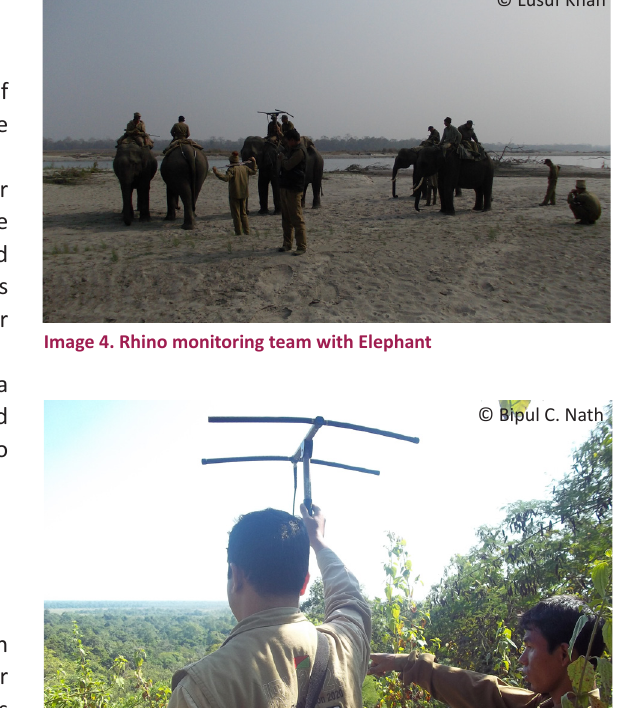
Image 5. Tracking rhinos from the top of the hill